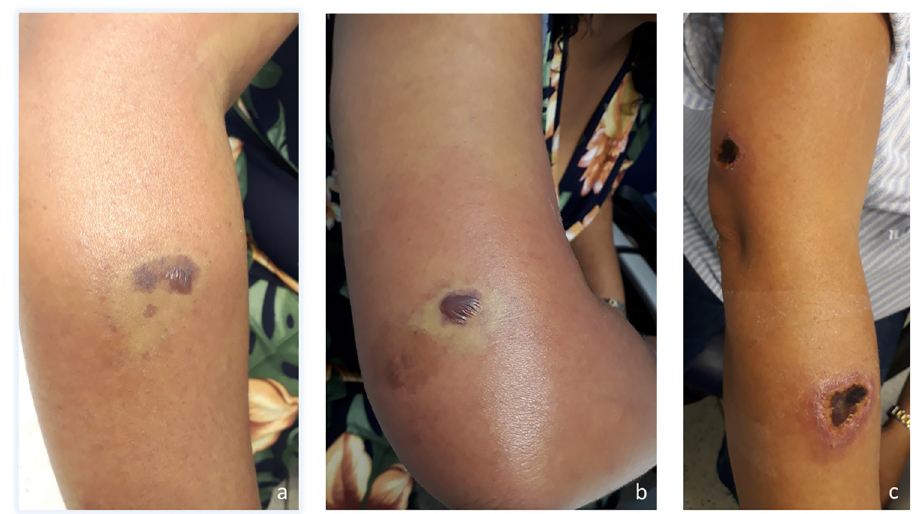
Fig 3. A patient bitten at two sites on the right arm. Marbled maculae on the forearm (a) and the upper arm (b), 4 days after a Loxosceles sp. bite. (c) Necrotic lesion on the upper arm and forearm 19 days after the bite.